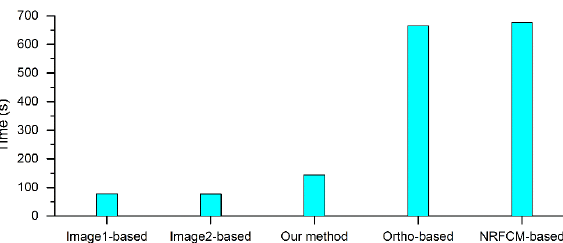
Figure 7. Retrieval efficiency of our method and the other four